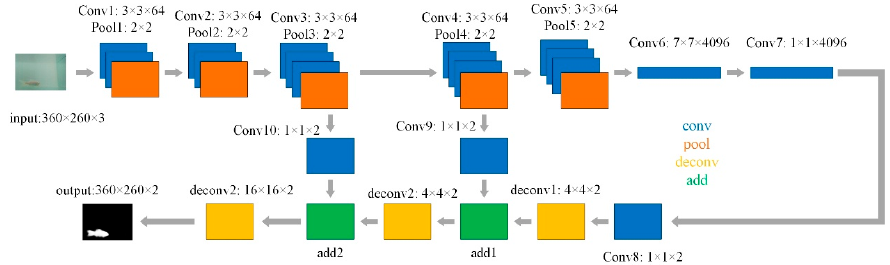
Figure 4. Fully convolutional network.